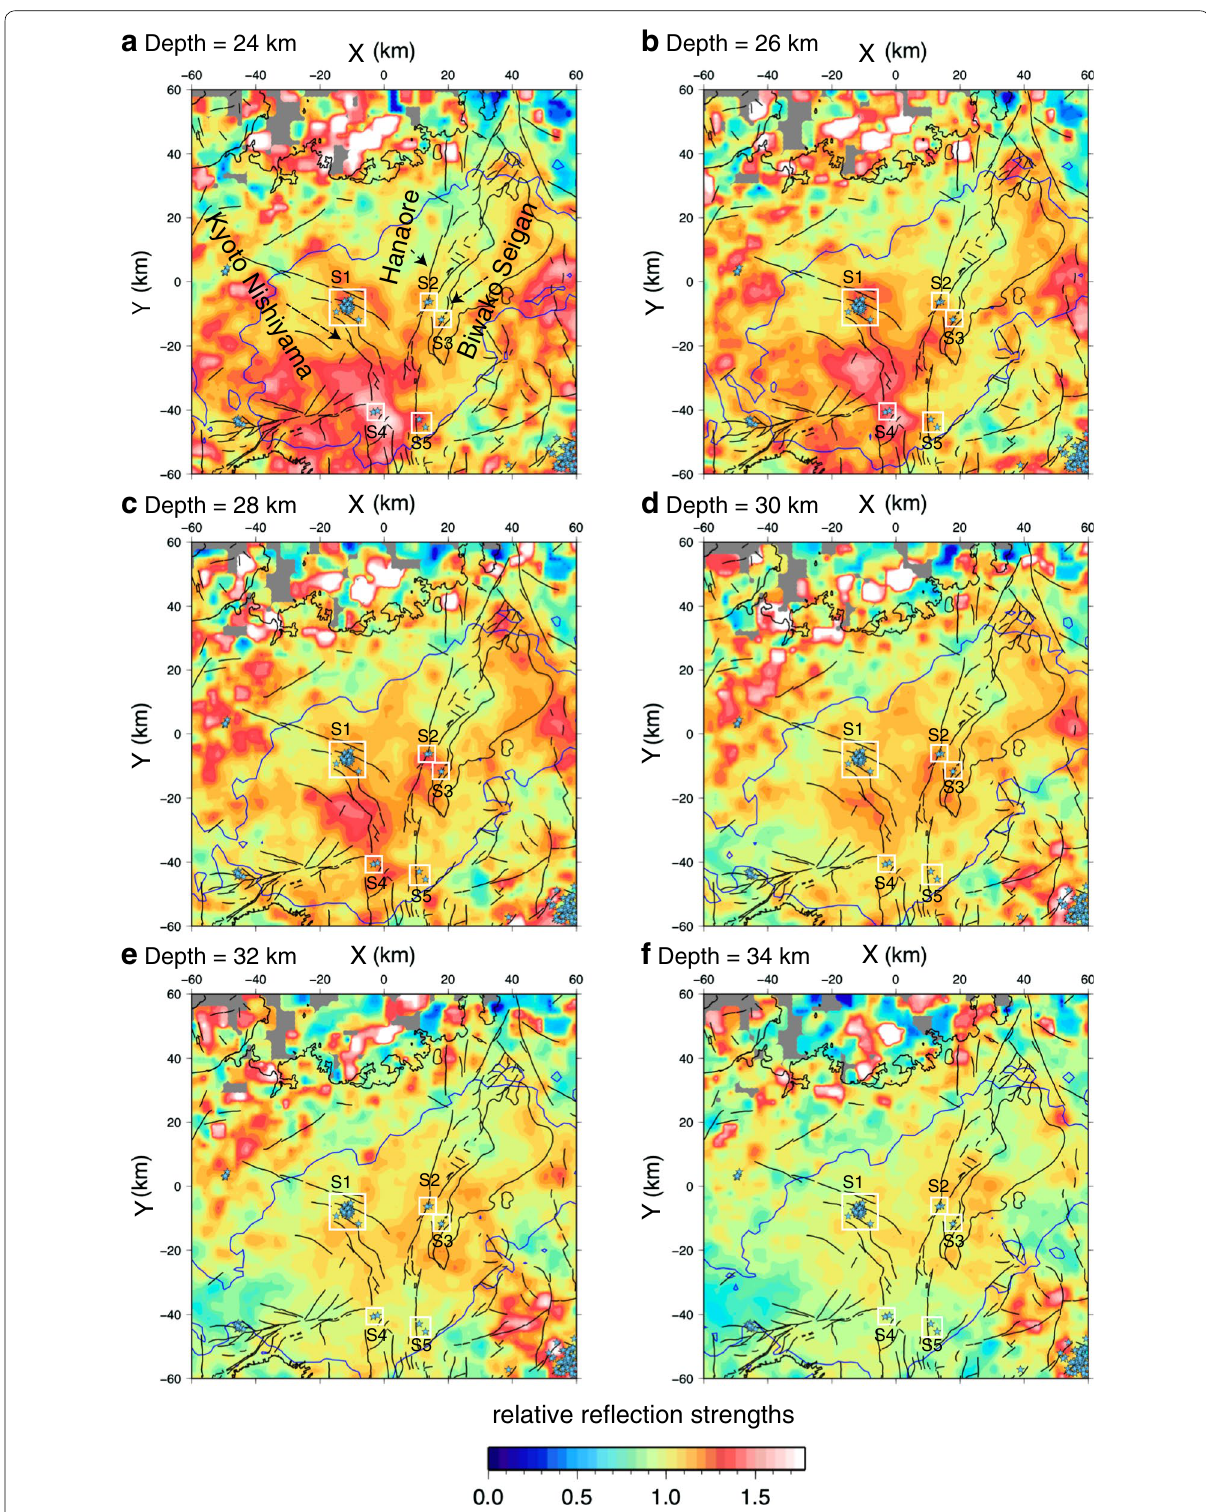
Fig. 3 Relative reflection strengths on horizontal cross section [depth 24, 26, 28, 30, 32, 34 km]. The blue line shows areas in which there are more = than 10,000 samples per grid cell. Black lines represent active faults. White squares represent hypocentral areas projected on the surface [S1, S2, S3, S4, and S5]. Hypocenters of DLFs are plotted regardless of their depth. The names of the fault zones [Kyoto Nishiyama, Hanaore, and Biwako Seigan] are putted near each fault